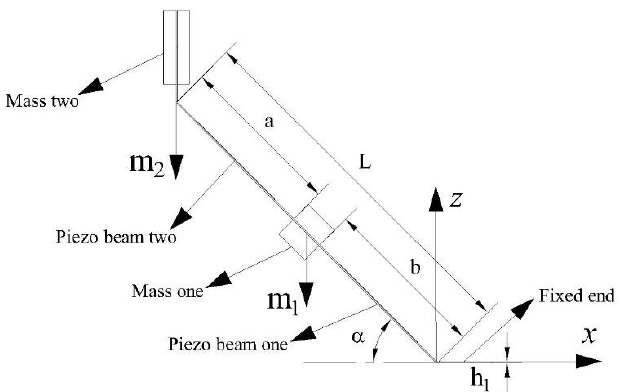
Figure 1. Structural diagram of two-degree-of-freedom diagonal beam.